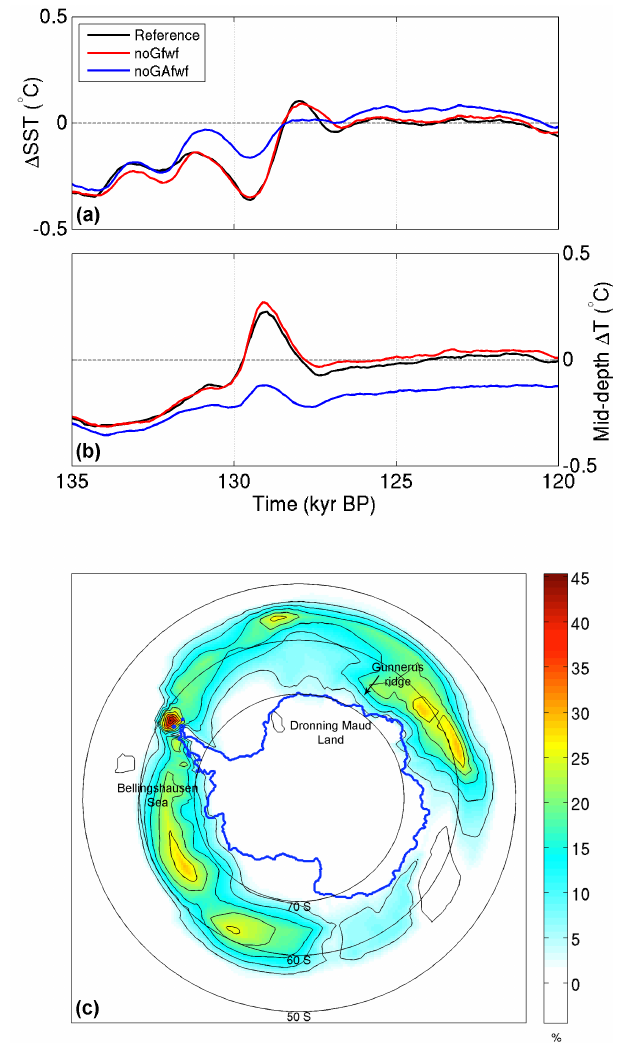
Figure 8. Evolution of annual mean sea surface temperature (a) and mid-depth (485–700m) ocean temperature (b) anomalies relative to the pre-industrial era in close proximity to the AIS (south of 63 ◦ S). (c) Meltwater-related changes in annual mean sea ice area at 129.5kyrBP from differences between experiments Reference and noAGfwf in per cent. The blue contour outlines the observed ice- shelf edge and grounded ice margin of the present-day AIS for il- lustration. All curves (a, b) are smoothed with a running mean of 200 years for better comparison.